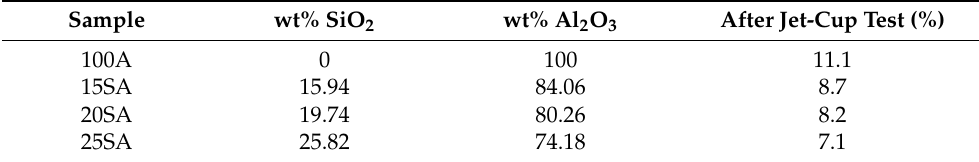
Table 1. Fines percentage (<20 µ m) obtained after jet-cup attrition test (for 1 h) of the SiO 2 –Al 2 O 3 microspheres.